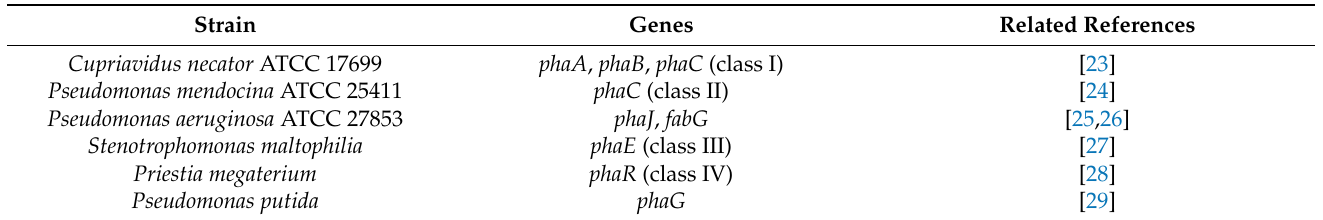
Table 1. The list of strains (collection and food isolates) with detected genes used as positive controls for multiplex